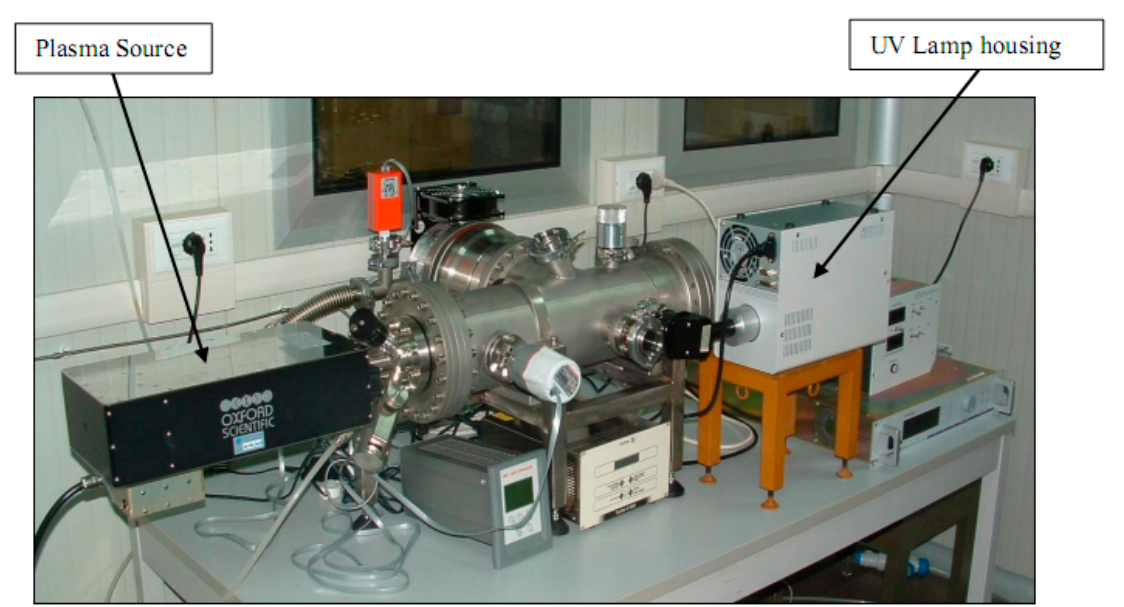
Figure 2. Picture of the UV/AtOx simulator test facility.